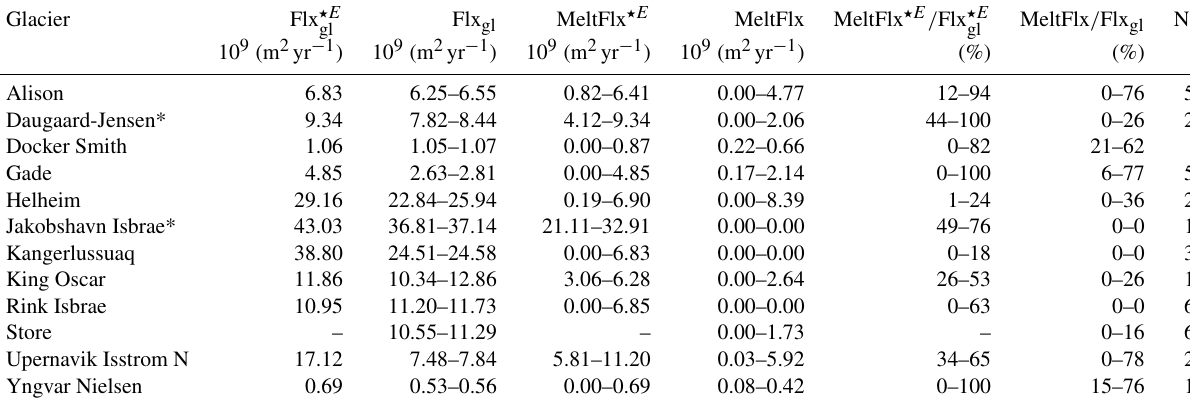
Table 2. Each investigated glacier with the mean grounding line discharge from observation Flx (cid:63)E (Enderlin and Howat, 2013) and from the gl stable-state simulations Flx gl as well as the number of stable simulations (No.). The melt flux range for floating termini from all present-day simulations MeltFlx and from the observational data MeltFlx (cid:63)E is calculated with the error ranges in Enderlin and Howat (2013) but with the condition 0 < MeltFlx (cid:63)E < Flx (cid:63)E . The respective ratio of melt flux /grounding line discharge (MeltFlx / Flx gl ) as a percentage is listed for gl the simulation and observations ( (cid:63)E ) and indicates how much ice that flows over the grounding line is lost by submarine melting. The sign * indicates glaciers for which the melt rate partition of the simulation does not overlap with the range of Enderlin and Howat (2013). Melt fluxes are derived for floating tongues and thus MeltFlx = 0 indicates tidewater glaciers (no floating tongue). Store Glacier is not examined in Enderlin and Howat